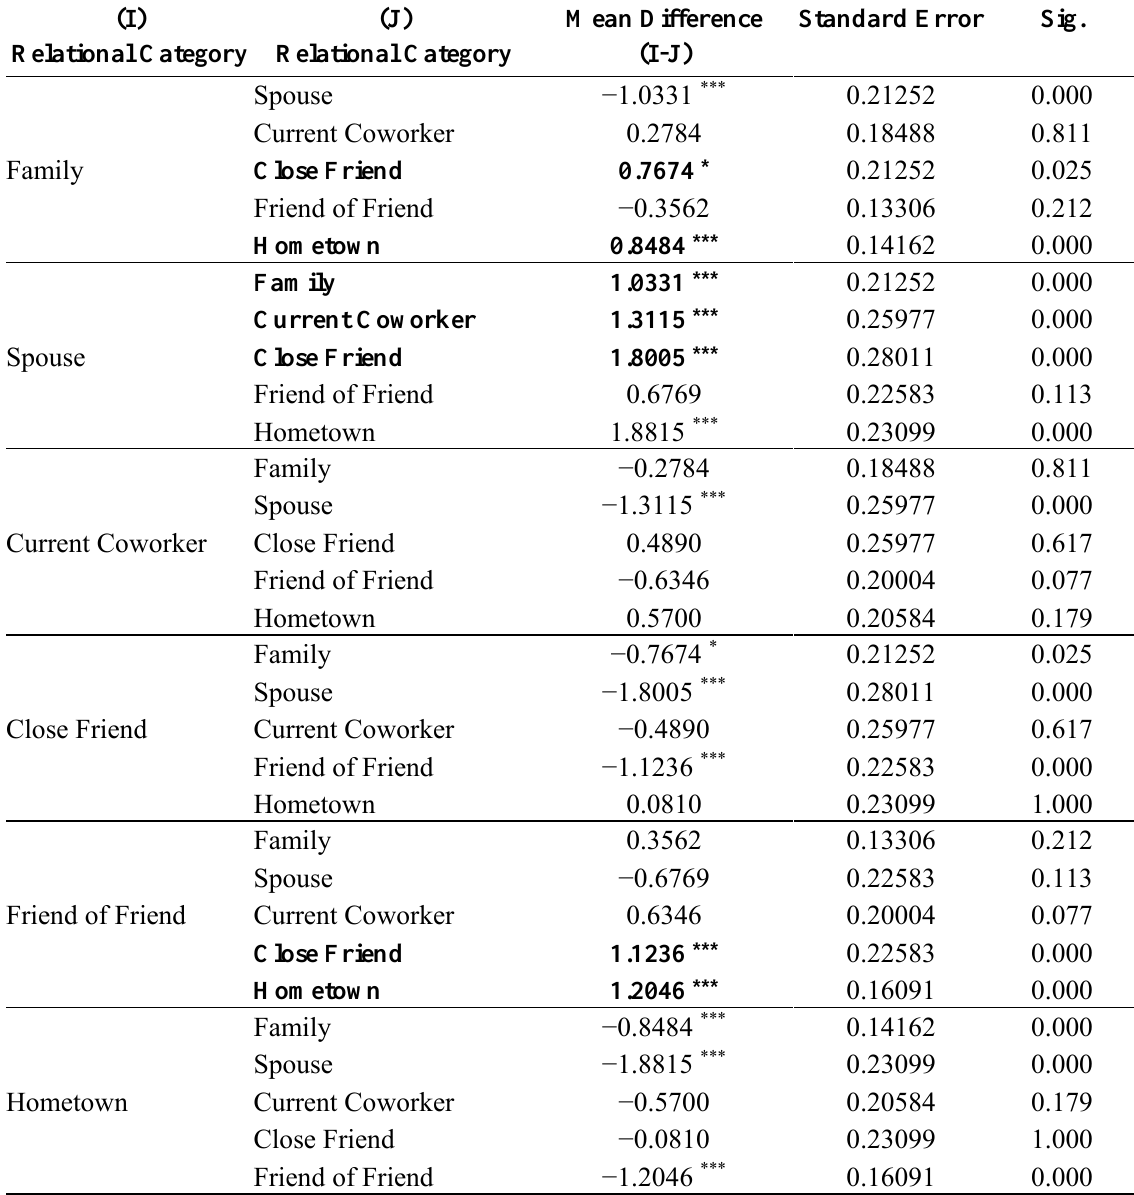
Table 6. Results of Scheffe Post-Hoc Test of Differences between Relational Category and Perceived Access to